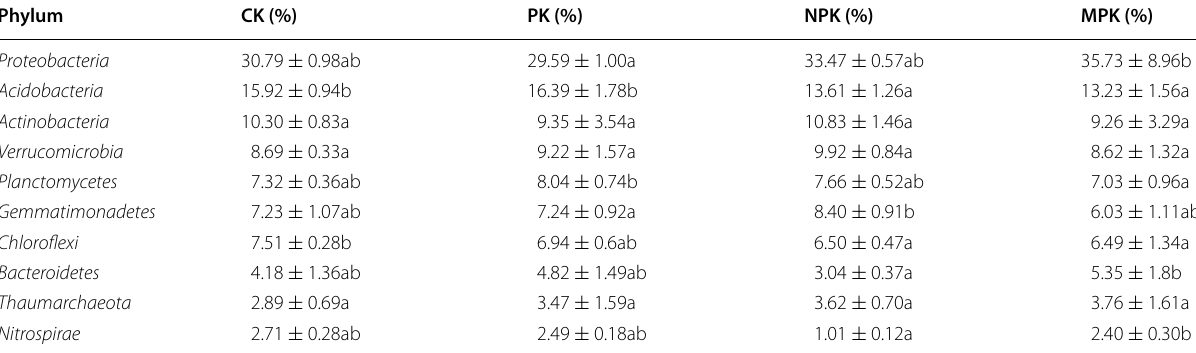
Values are mean standard deviation (n 6). Values within the same column followed by different lowercase letters indicate significant differences according to ± = Tukey’s multiple comparison tests